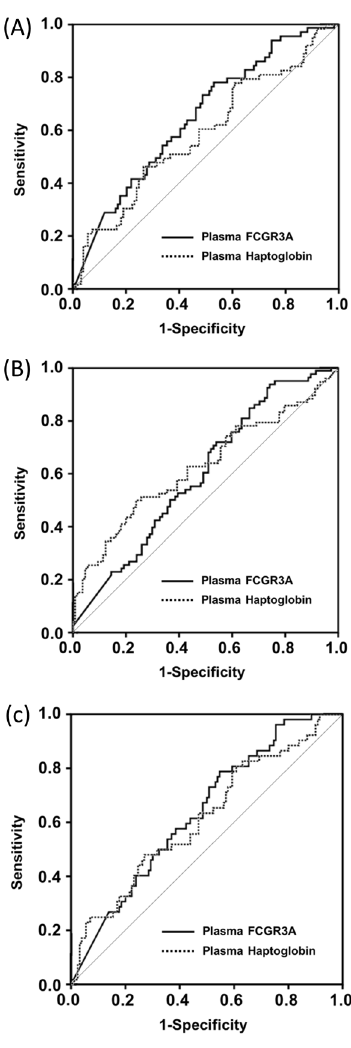
Figure 3. ROC curves of plasma FCGR3A and haptoglobin for preicting ( A ) MIAC, ( B ) IAI, and ( C ) microbial-associated IAI. ROC receiver-operating characteristic, FCGR3A low affinity immunoglobulin gamma Fc region receptor III-A, MIAC microbial invasion of the amniotic cavity, IAI intra-amniotic